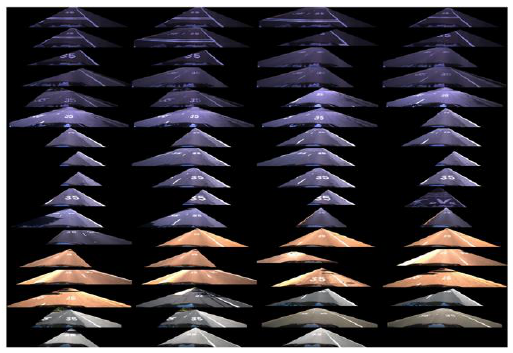
Figure 13. Montage of segmented training data for class '35' used for Colour CNN